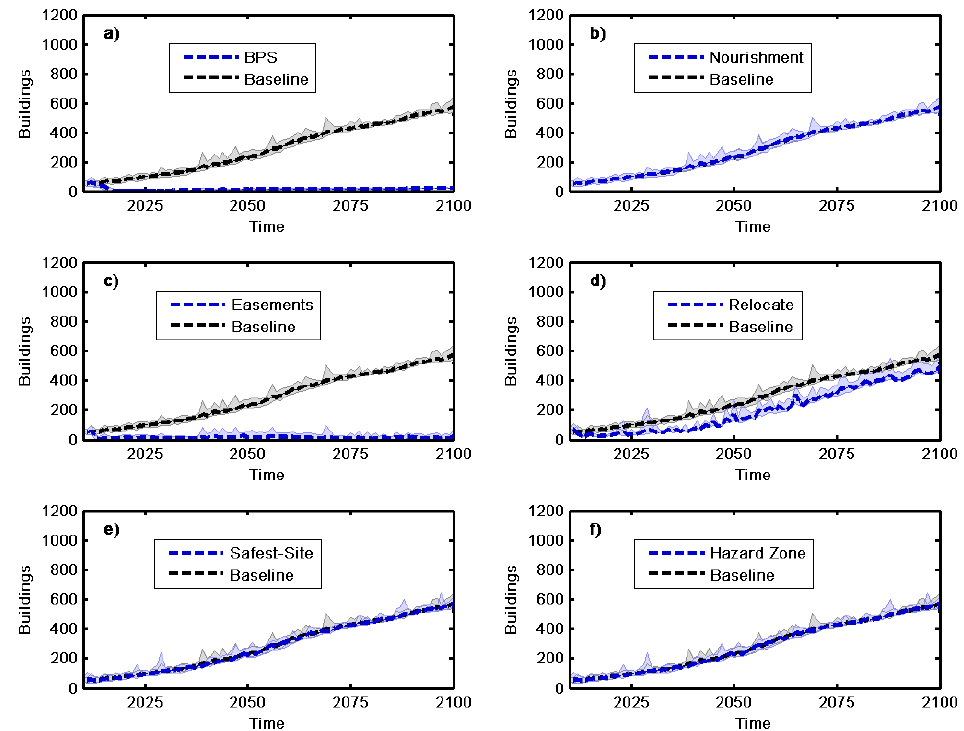
Figure 7. Number of buildings impacted by erosion through time under each of the six policy drivers (panels a – f ) compared to the baseline. Dashed lines indicate the decadal mean of all simulations. Bounds represent the minimum and maximum decadal means.